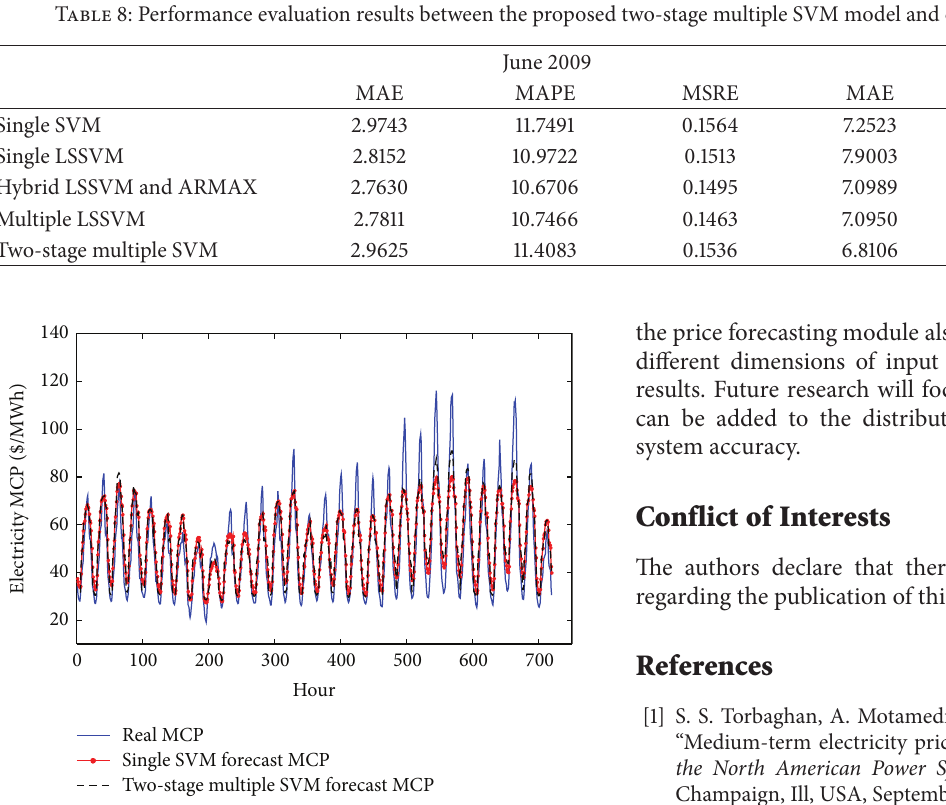
Figure 5: Forecasted electricity MCP in June 2010 using both single and two-stage multiple